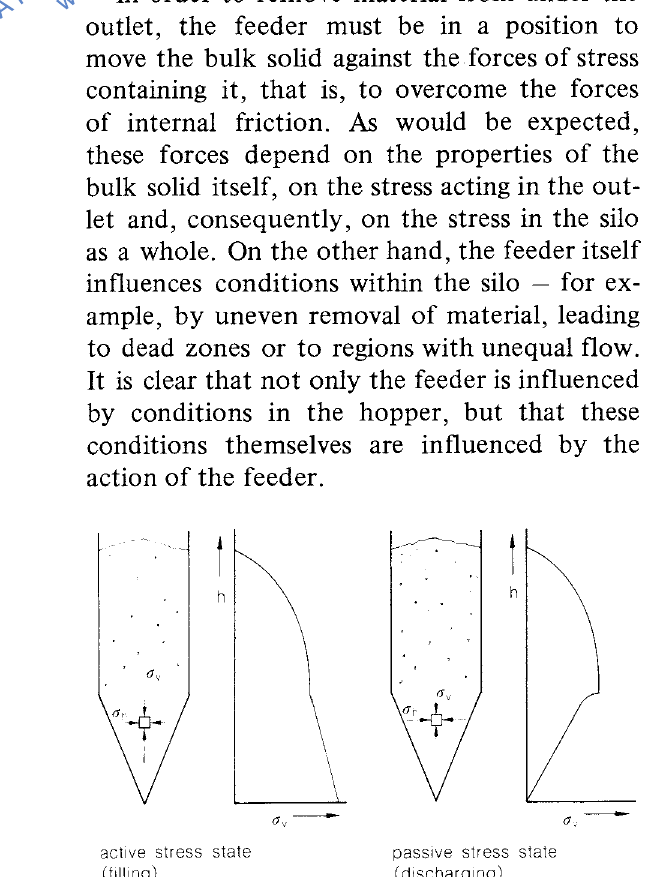
Fig. 1.2 Active and passive stress fields within the